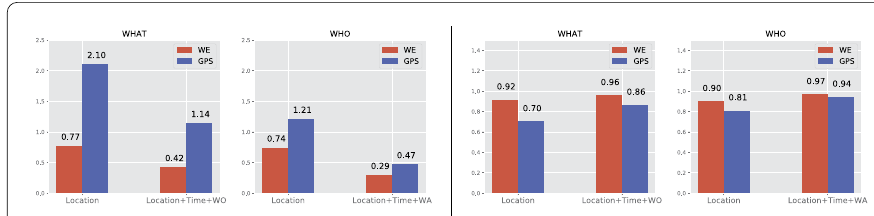
Figure 8 Entropy (left) and predictability (right) of modality WA and WO after conditioning on subjective labels (red) and objective labels